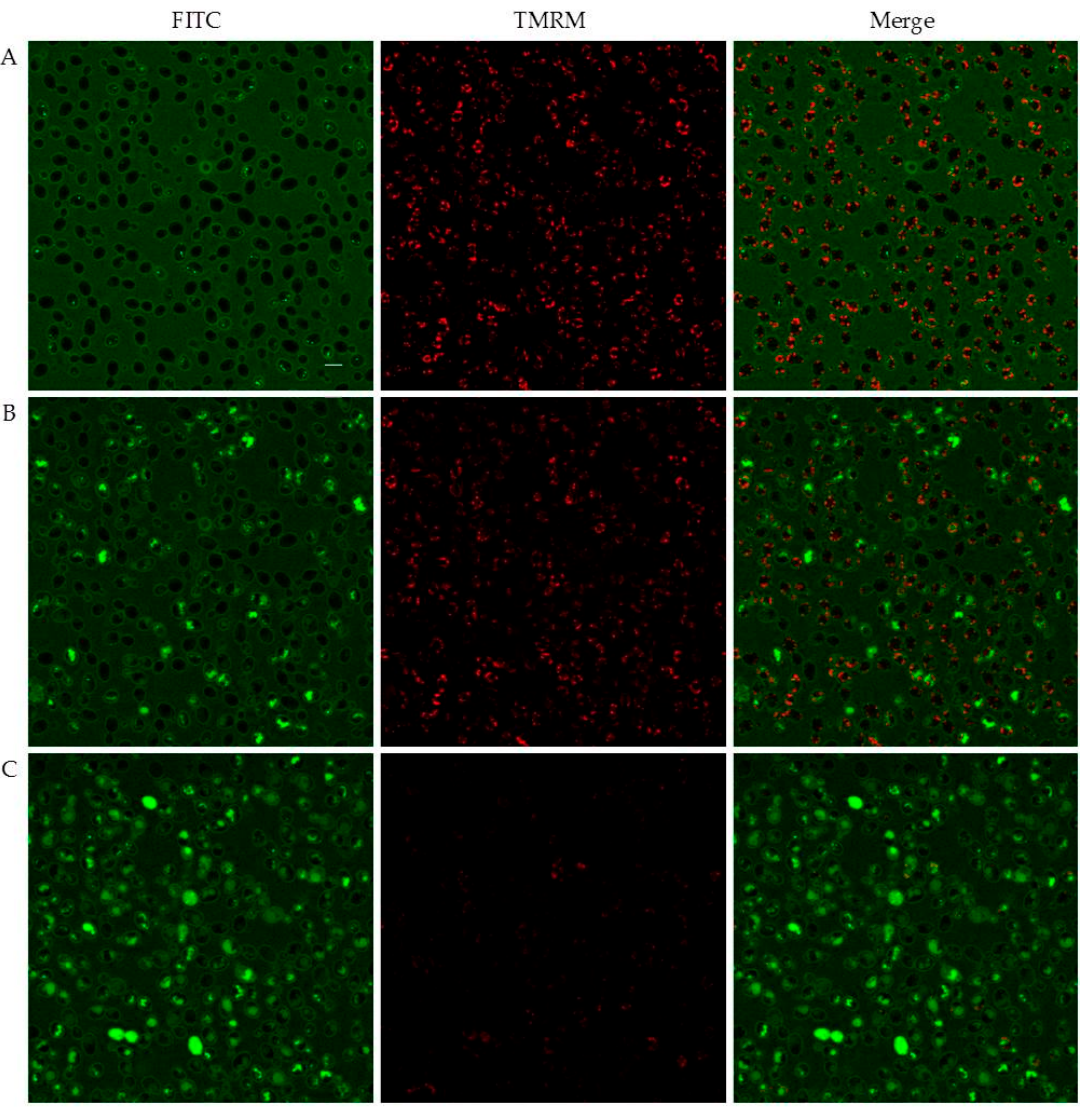
Figure 7. Confocal images of living Candida albicans SC5314 cells pre-treated for 1 h with tetramethylrhodamine methyl ester perchlorate (TMRM) after addition of FITC-labelled D5A for 5 min ( A ), 60 min ( B ), and 165 min ( C ). Bar = 5 μ m.